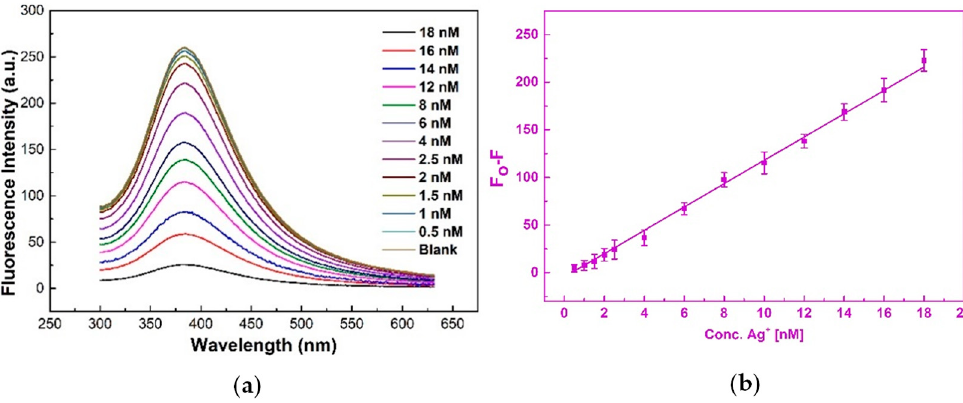
Figure 7. ( a ) Ag + + N-CQDs solution fluorescence intensity at different metal concentrations. ( b ) Plot of fluorescence intensity difference between the reference solution (blank) and the N-CQDs Ag + solutions at different concentrations.